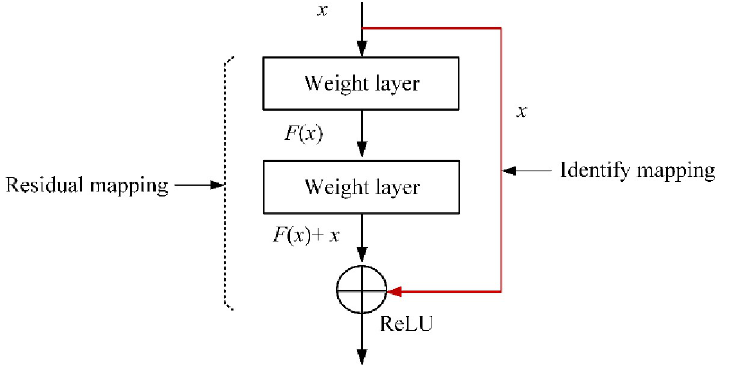
Fig 6. The structure of a residual